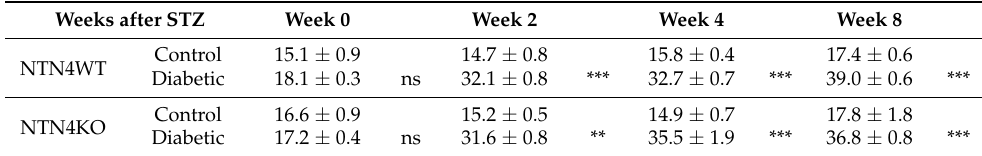
Table 1. Blood glucose levels after diabetes induction 1 .